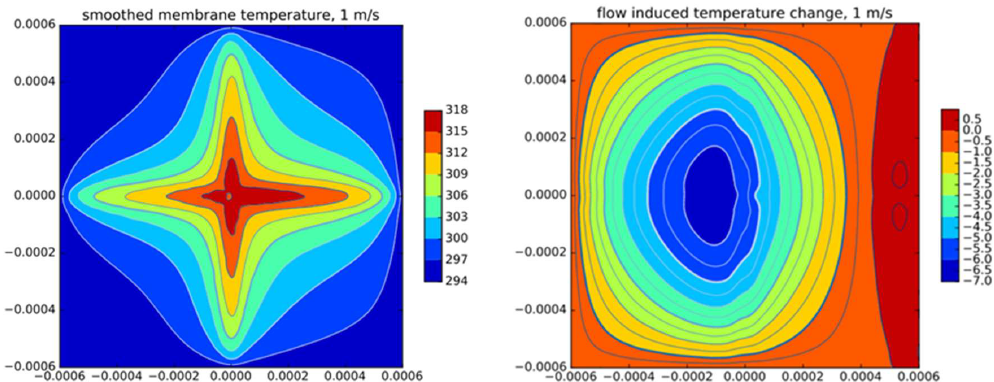
Figure 9. ( Left ): Contour plot of the membrane temperature field for a flow rate of 1 m / s from left to right. ( Right ): Corresponding contour plot of the convection induced temperature change in Kelvin at the surface of transducer membrane. A total heating power of 3 mW is applied.